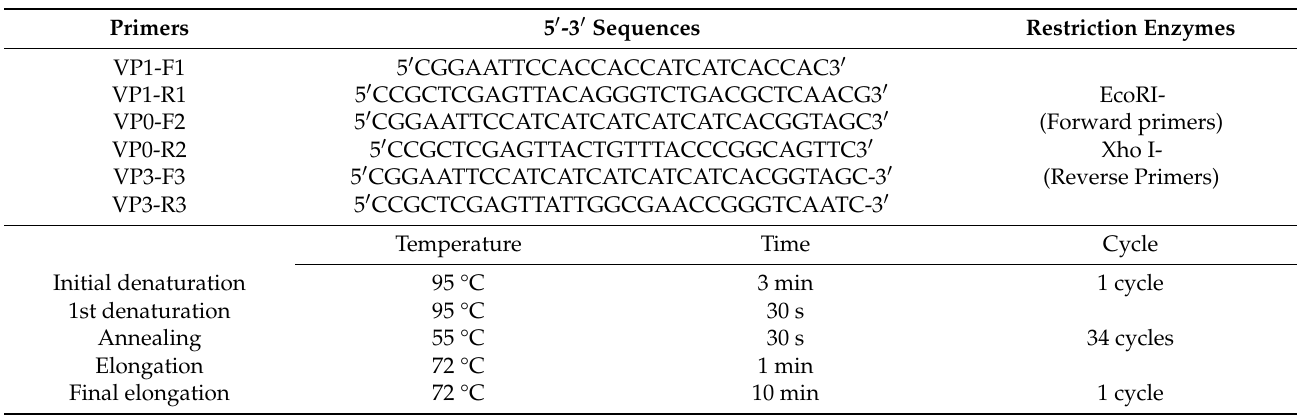
Table 1. The forward and reverse primers along with appropriate restriction endonuclease enzyme (underlined in the primer sequence) that amplify the three structural protein-encoding